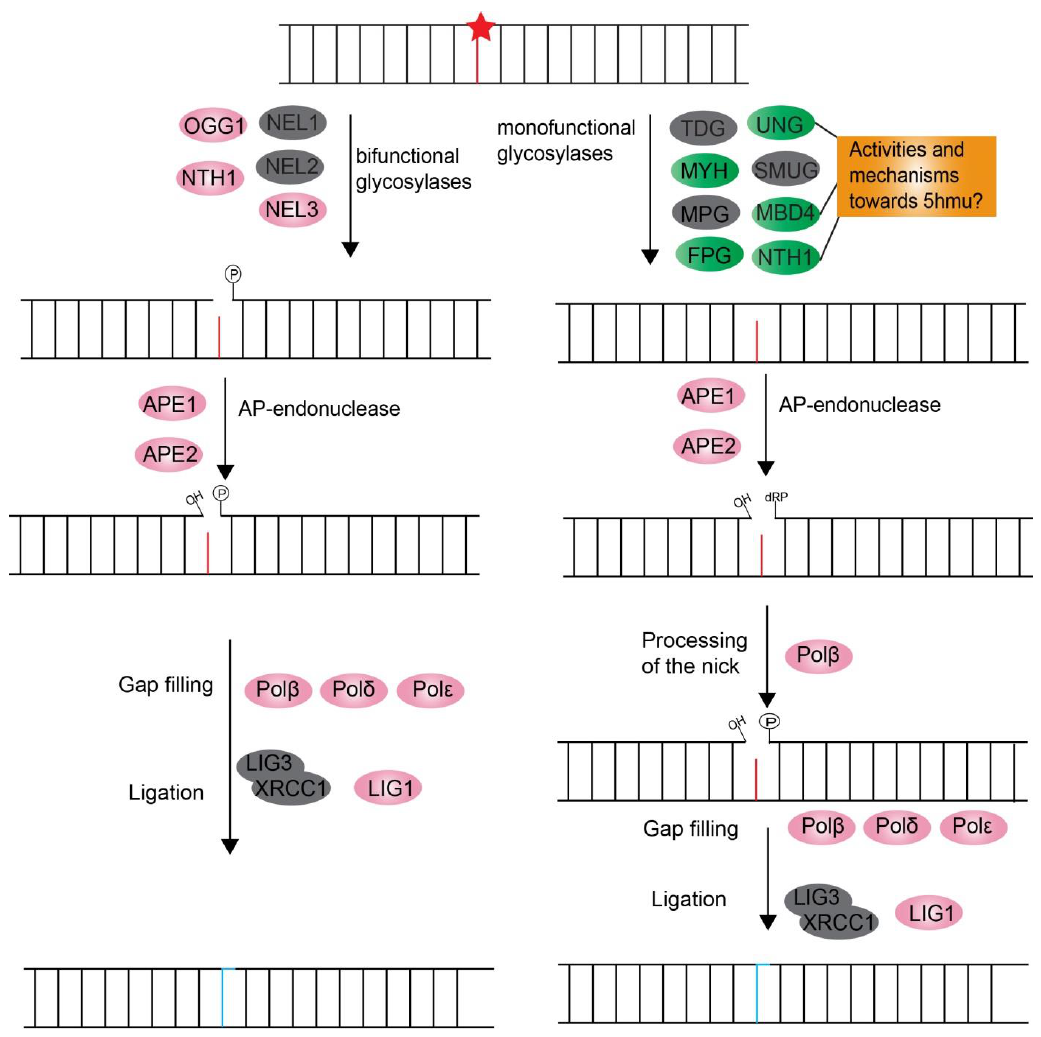
Figure 3. Diagrammatic summary of dinoflagellate orthologues predicted in the base excision repair pathway. The ellipses filled with grey color mean the absence of putative dinoflagellate orthologues in the searched transcriptomes. The other colors in ellipses indicate the presence of putative dinoflagellate orthologues.